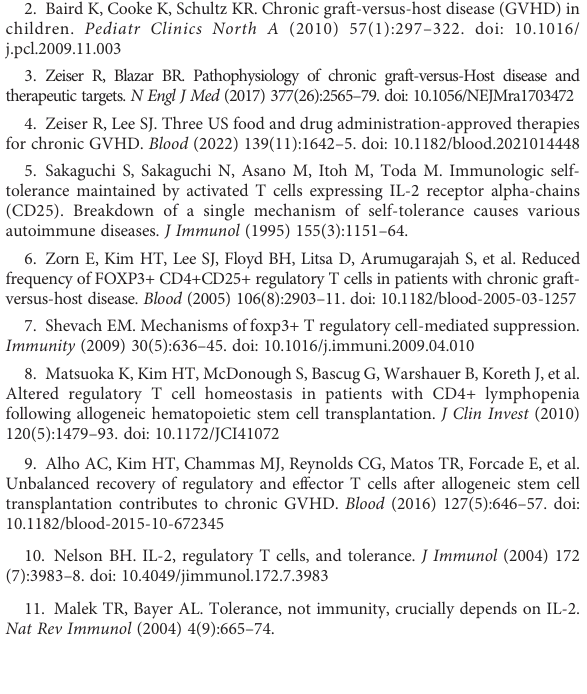
SUPPLEMENTARY FIGURE 1 Absolute Treg counts before and after IL-2 discontinuation. (A) Fold change from baseline prior to LD IL-2 discontinuation. Values at all time points, including the Treg count prior to starting LD IL-2 therapy (Pre IL-2) were normalized to the absolute Treg count for each patient at the last time point prior to stopping LD IL-2. (B) Absolute Treg count trends over time are shown for each individual patient. * p < 0.05. SUPPLEMENTARY FIGURE 2 Impactof IL-2 discontinuation onnaïve and memoryT-cell compartments. ThefractionofnaïveTcellswithinTreg,Tcon,andCD8+T-cellsovertimeis represented by orange lines. The fraction of memory T cells within the various T cell subtypes is represented by gray lines. The memory fraction includes effector memory, central memory, and TEMRA T cells. Patients ’ data is displayed in individual rowsand patients are designated by their case numbers. Treg, CD4+ regulatory T cell; Tcon, CD4+ conventional T